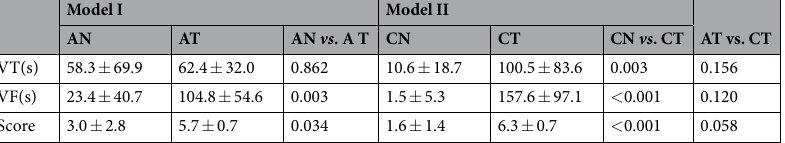
Table 1. Electrophysiological parameters of the experimental models. Notes: AN, AT: the control and LVTA group in Model I, respectively; CN, CT: the control and LVTA group in Model II, respectively; AN vs. A T, CN vs. CT, AT vs. CT: P -value calculated by a t -test between AN and AT, CN and CT, and between AT and CT, respectively. The data are presented as “mean ± SD”.